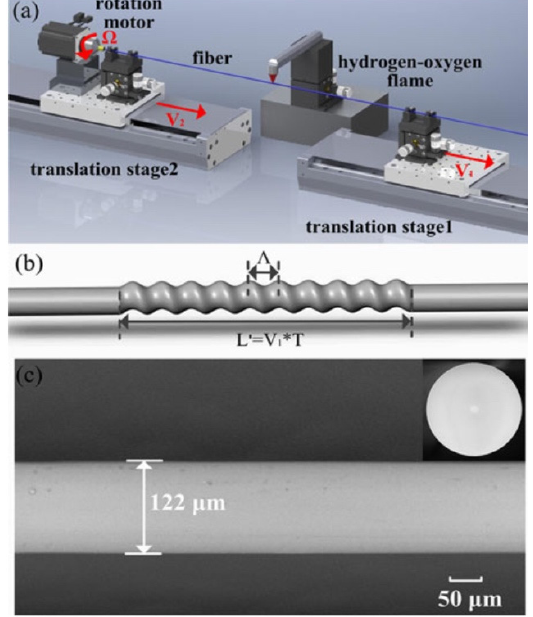
Figure 14. ( a ) Schematic diagram of HLPG inscription by use of a hydrogen-oxygen flame. ( b ) Schematic diagram of periodic helical structures solidified in the fiber. ( c ) Scanning electron micrographs of the side view and cross-section (inset) of an inscribed HLPG sample. © [2021] IEEE. Reprinted, with permission, from Ref. [15] .